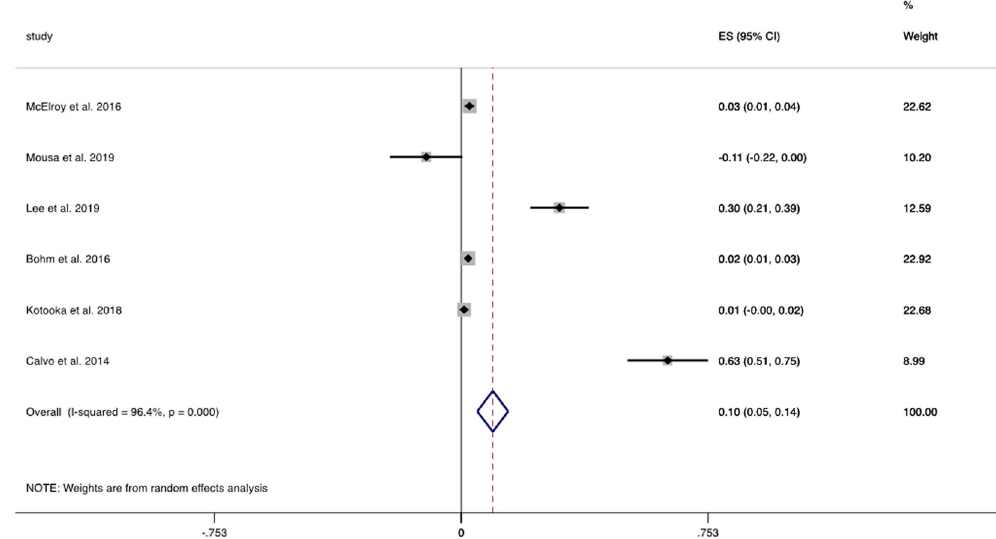
Fig. 2 Forest plot hospitalisation. Forest plot of studies reporting hospitalisation and inpatient admissions.